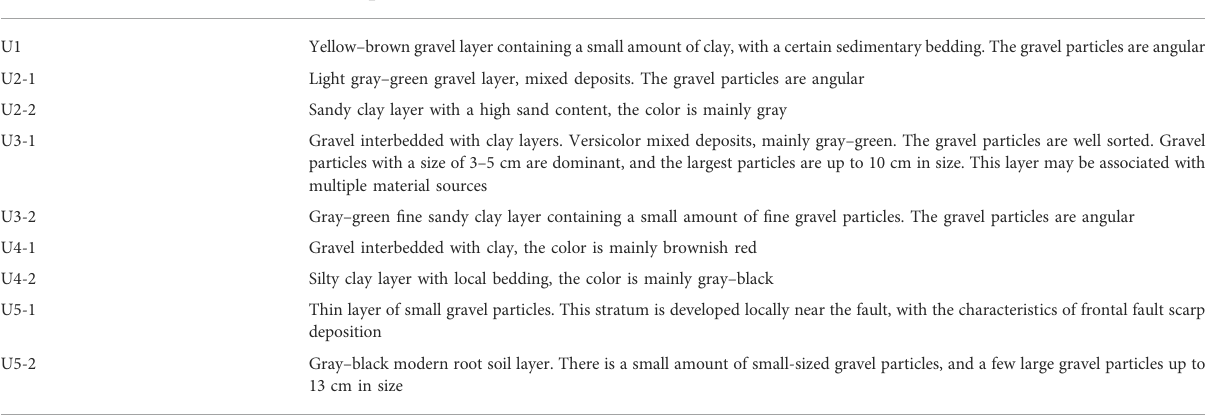
TABLE 1 Unit description of trench GQ1. Unit